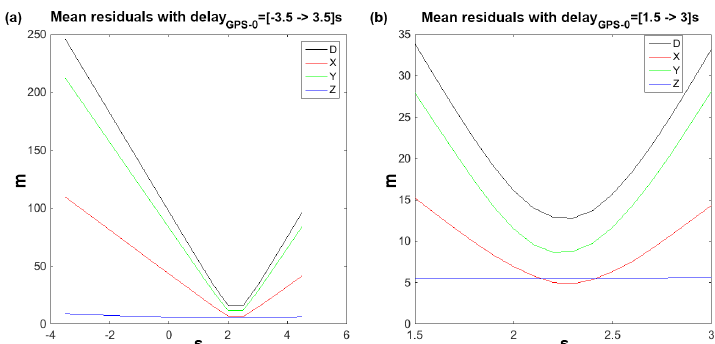
Figure 2. Mean residuals in x , y , and z and Cartesian distance D of differences between raw GPS positions and SfM-reconstructed relative positions, as a function of different start-time Delay GPS-Camera0 offsets between GPS and camera. Search area (a) from − 3.5 to + 3.5s in 0.5s increments and (b) from 1.5 to 3.0s in 0.1s increments. The best value is found at ≈ Delay GPS-0 = 2 . 3 s . Note that the z coordinate is nearly independent of Delay GPS-Camera0 because the flight used here was mostly at a constant altitude.